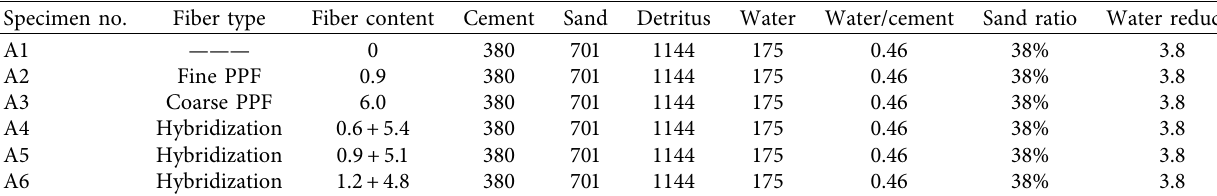
Table 2: Mixture proportion (kg/m 3 ).